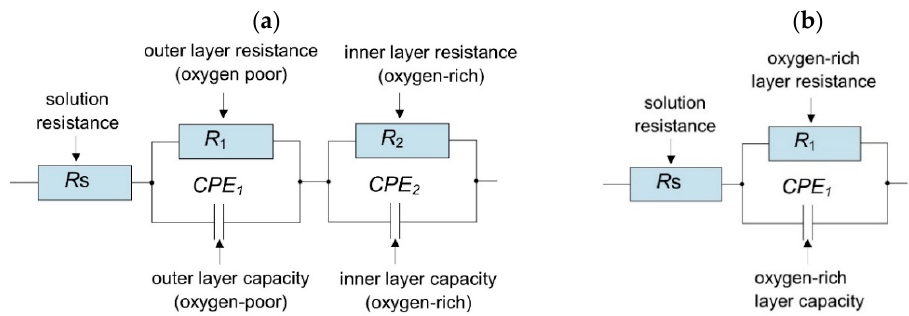
Figure 6. Equivalent circuits of the Electrochemical Impedance Spectroscopy EIS spectra: ( a ) two-layer model, and ( b ) one-layer model.